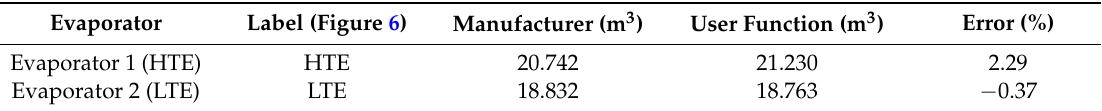
Figure 7. Liquid volume as a function of the liquid level in Evaporator 1 (HTE) and Evaporator 2 (LTE) in Sauerlach. Table 1. Computed volume in comparison with values given by the manufacturer. HTE: High temperature evaporator; and LTE: low temperature